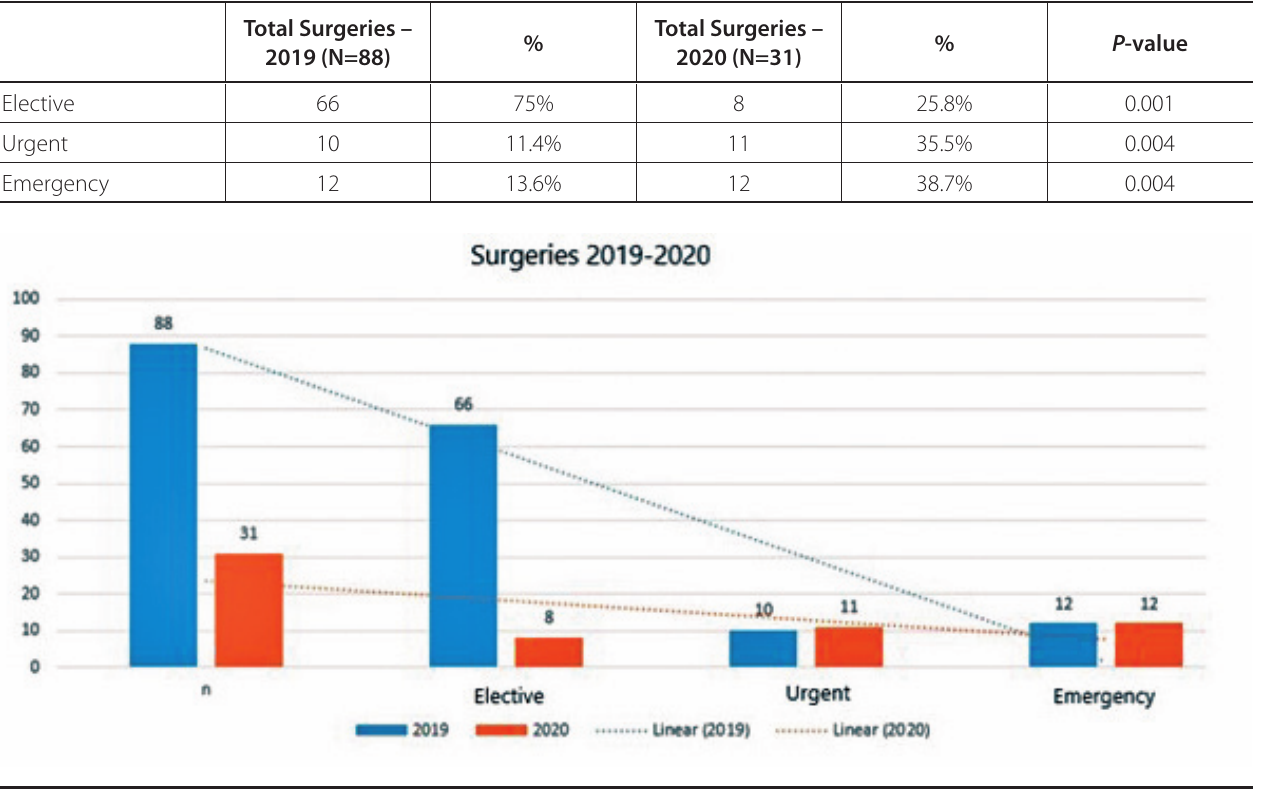
Table 1 . Total number of surgeries from April 1 st to July 31 st (2019 and 2020), specifying its elective, urgent, and emergency character and its variation between the two